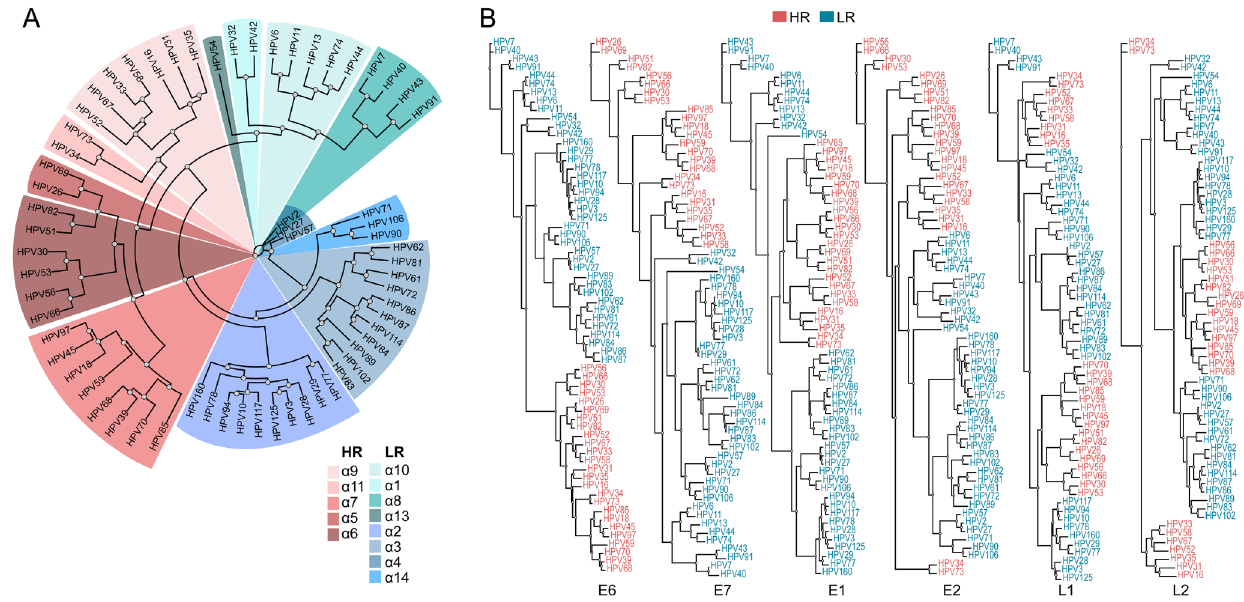
Figure 1. Phylogenetic trees of alpha-HPV. ( A ) Maximum likelihood tree obtained with the whole genome nucleotide sequences alignment of alpha-HPV, colored by the different alpha-class categories. ( B ) Maximum likelihood trees obtained with alignments of E6, E7, E1, E2, L1 and L2 amino acid sequences of alpha-HPV, colored by the oncogenic risk